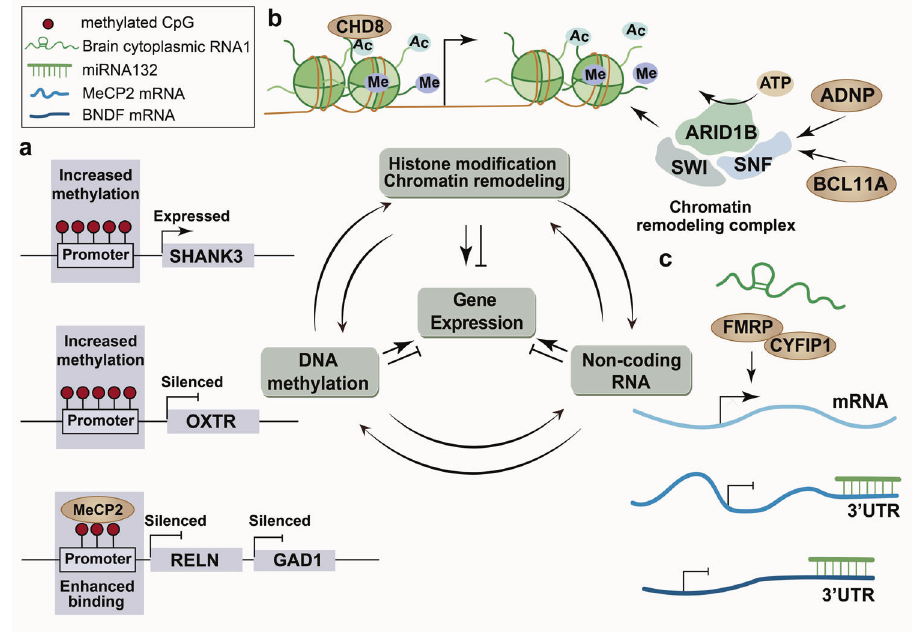
Fig. 5 The epigenetic network associated with ASD pathophysiology. a Despite the exceptions, DNA methylation usually leads to transcriptional repression or even silencing of the affected gene. MeCP2 binds to methylated CpG sites in gene promoters and associates with chromatin silencing complexes, thereby suppressing gene expression. b Histone modi fi cation and chromatin remodelling cause transcriptional activation or inactivation, and chromatin packaging. c Non-coding RNAs control the expression of genes at the level